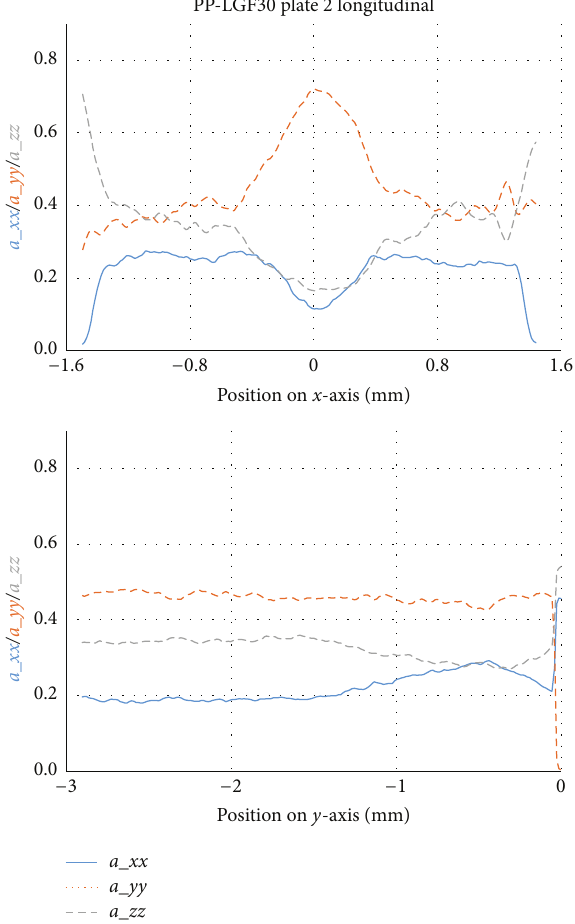
Figure 10: Progress of the fiber orientation along the 𝑥 - and 𝑦 -axis in a plate of PP-LGF30 with initial fiber orientation being transverse to the joining direction (hot plate welding).